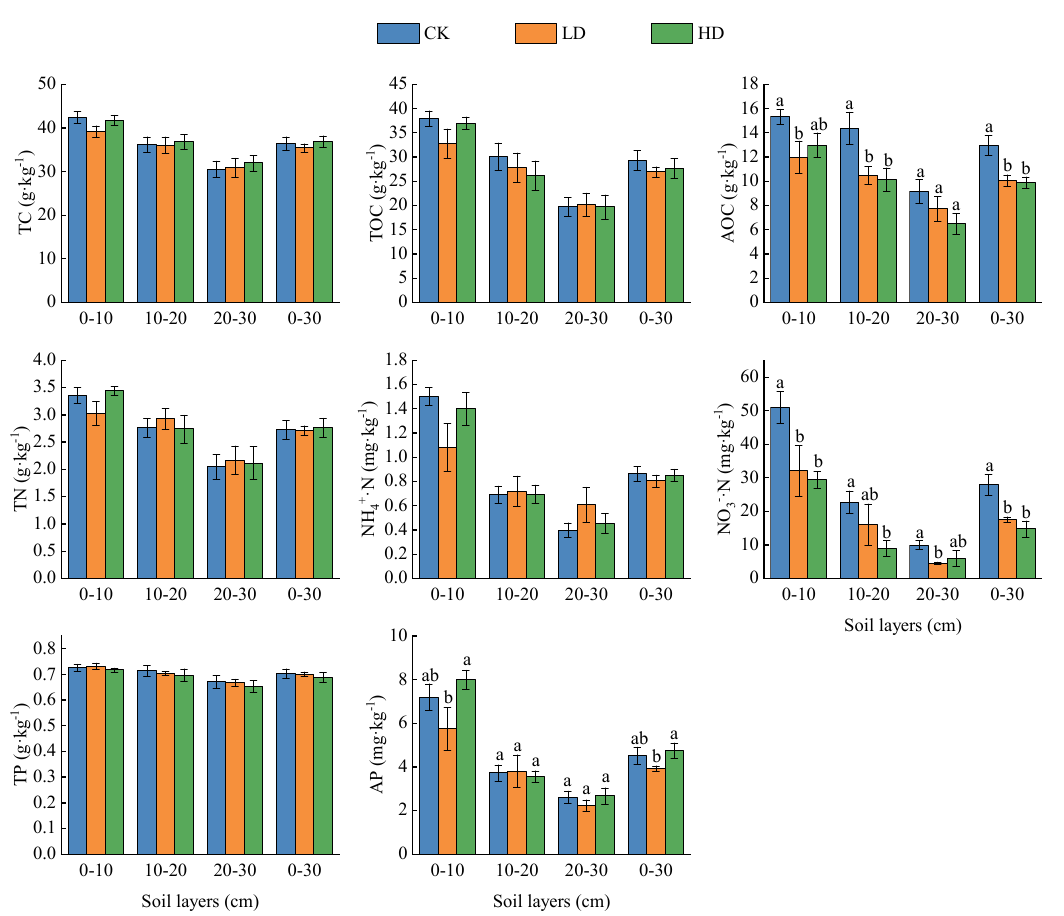
Figure 6. Soil nutrients of P. kansuensis patches in different densities.